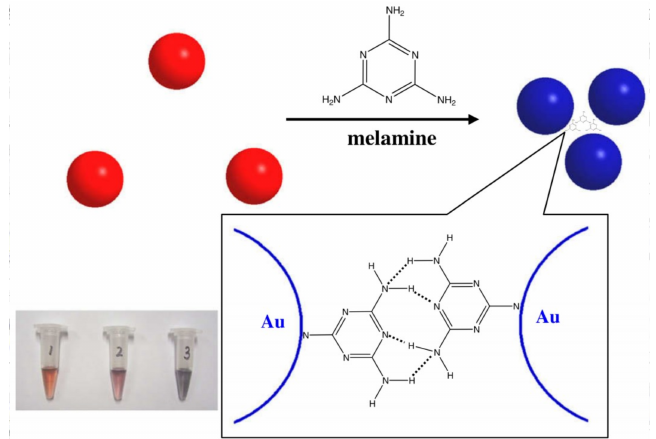
Figure 16. Schematic representation of the GNPs colorimetric mechanism for melamine detection. The insert is photographs of solution of (1) 400 µL GNPs + 20 µL H 2 O, (2) 400 µL GNPs + 20 µL melamine (5 × 10 –3 g/L), and (3) 400 µL GNPs + 20 µL melamine (20 × 10 –3 g/L). Experimental condition: GNPs, 1.4 µ M; incubation time, 1 min; reaction temperature, room temperature (~20 ◦ C).